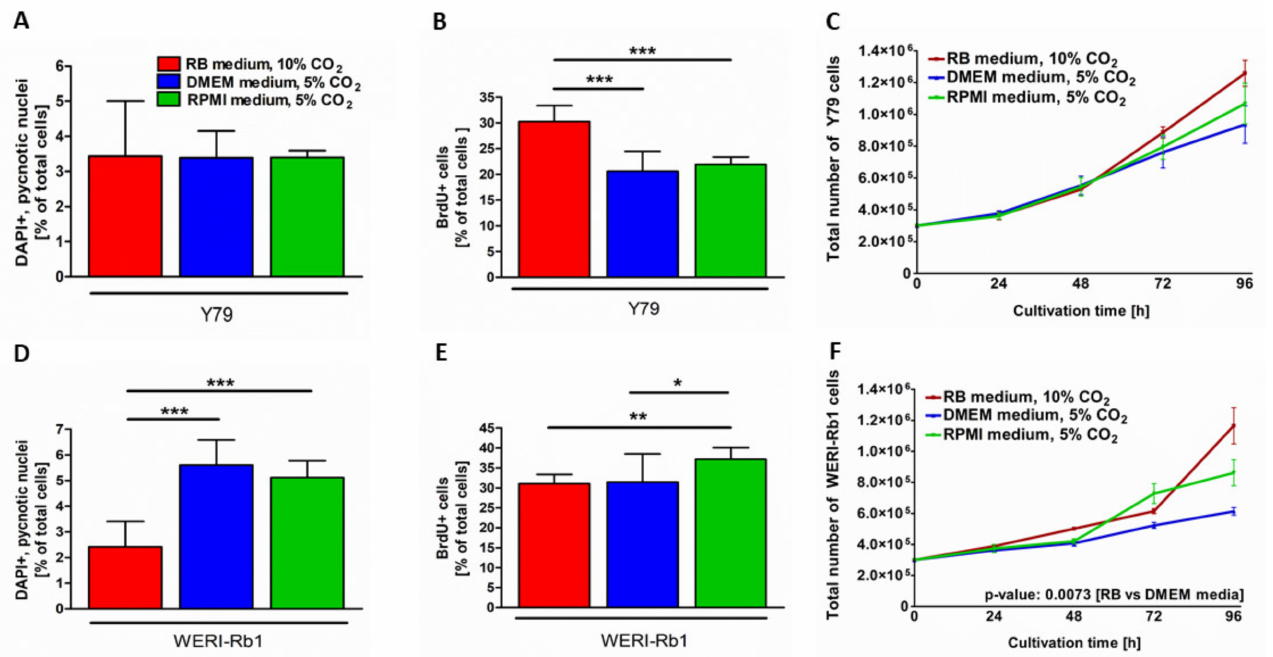
Figure 2. Effects of different cell culture conditions on apoptosis, proliferation, and growth kinetics of Y79 and WERI-Rb1 RB cell lines. The different cell culture conditions had an impact on apoptosis, pro- liferation and RB cell growth of Y79 and WERI-Rb1 cells as revealed by DAPI cell counts ( A , D ), BrdU stains ( B , E ) and growth curves ( C , F ). Values are means of three independent experiments ± SEM. * p < 0.05, ** p < 0.01, and *** p < 0.001; statistical differences calculated by one-way ANOVA with Newman–Keuls